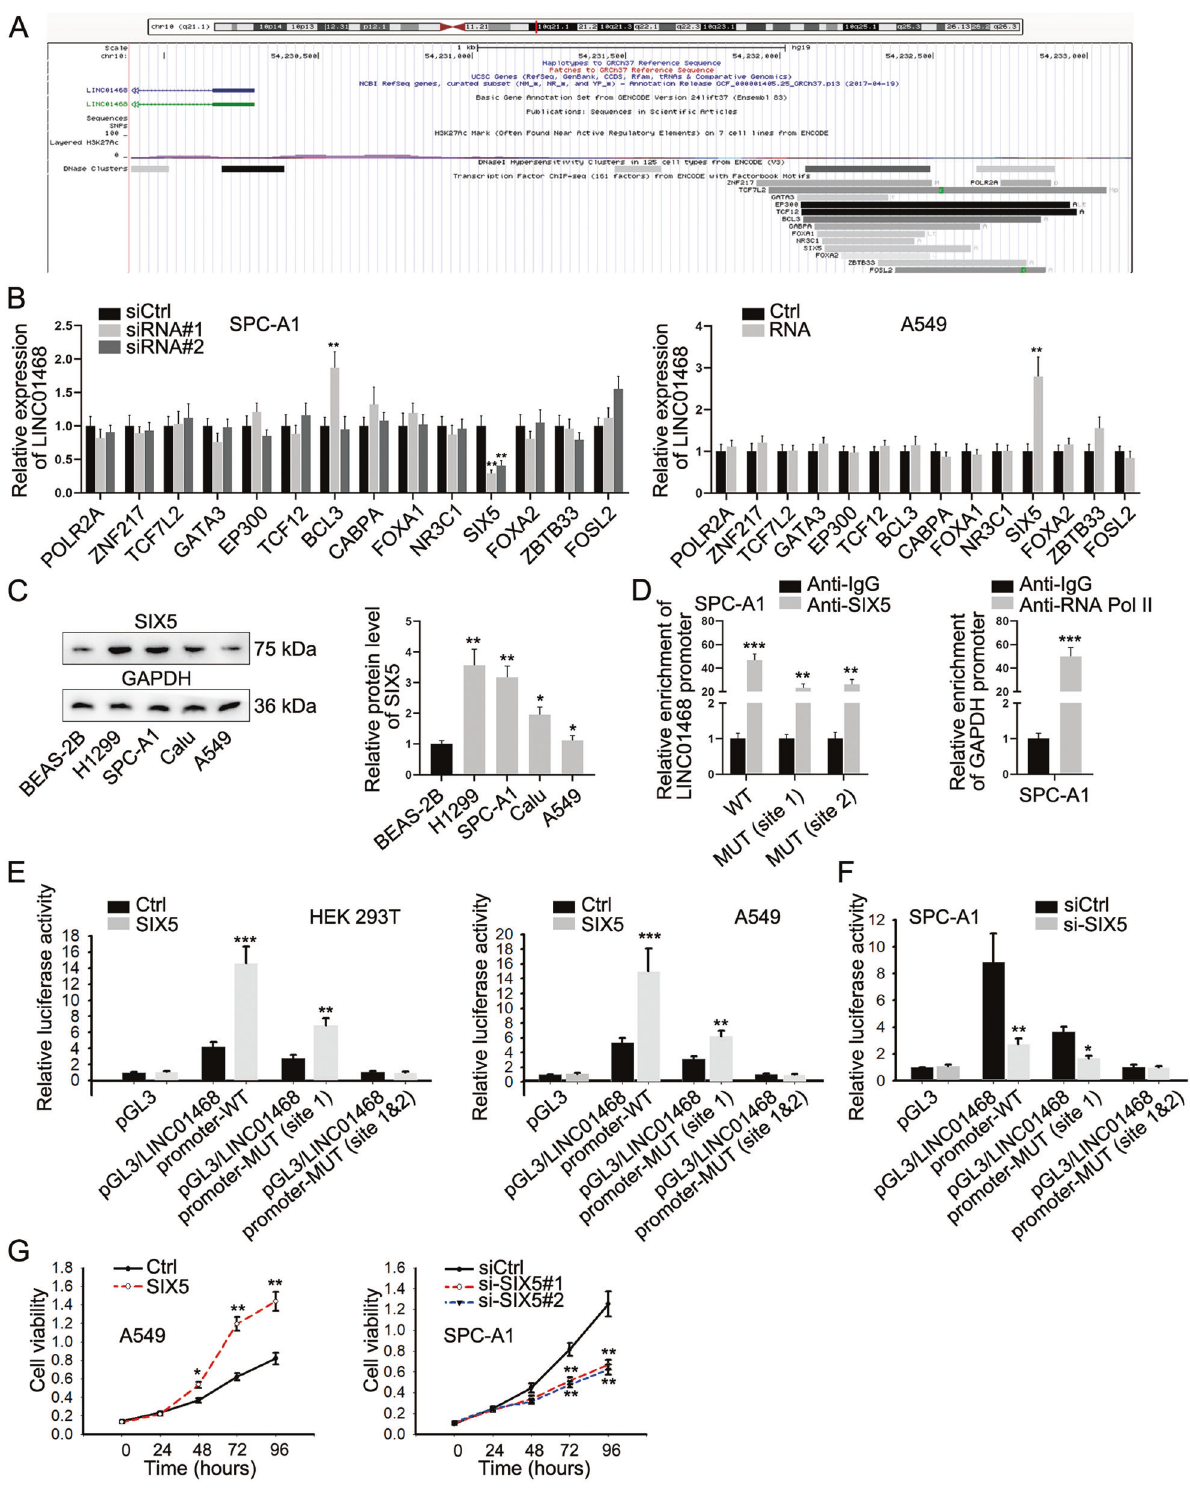
Fig. 3 SIX5 contributes to LINC01468 upregulation in LUAD cells. A UCSC was applied for prediction of candidate transcription factors for LINC01468. B The alterations in LINC01468 after knocking down or overexpressing candidate transcription factors were assessed via RT-qPCR, respectively. C Expression level of SIX5 in LUAD cell lines and normal cell line was measured via western blot analysis. D The af fi nity of SIX5 and LINC01468 promoter was determined by ChIP assay. E , F The impact of SIX5 on the transcriptional activity of LINC01468 was determined by luciferase reporter assay and the exact binding site of SIX5 on LINC01468 promoter was veri fi ed. G Proliferative ability of cells with SIX5 overexpression or silence was assessed by CCK-8 assay. Results were exhibited as the mean ± SD on the basis of three independent experiments. * p < 0.05, ** p < 0.01, *** p < 0.001 indicated the statistical signi fi cance of experiments data.